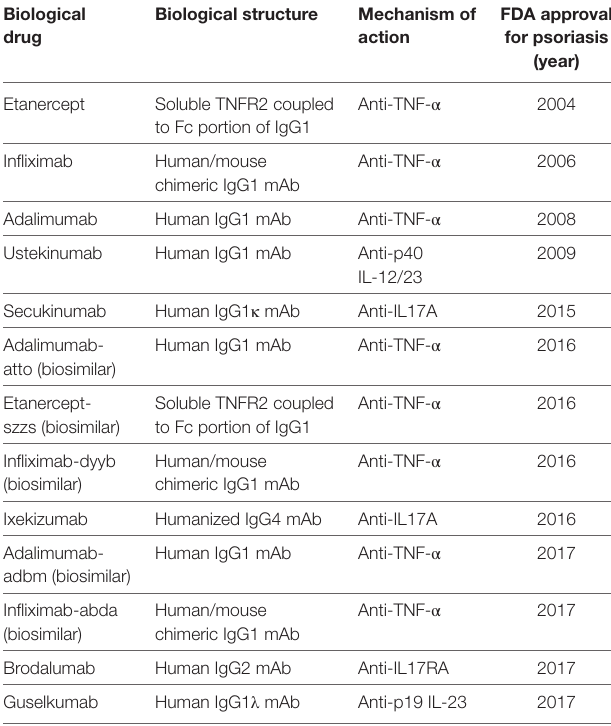
TABLe 2 | FDA approval biological drugs for